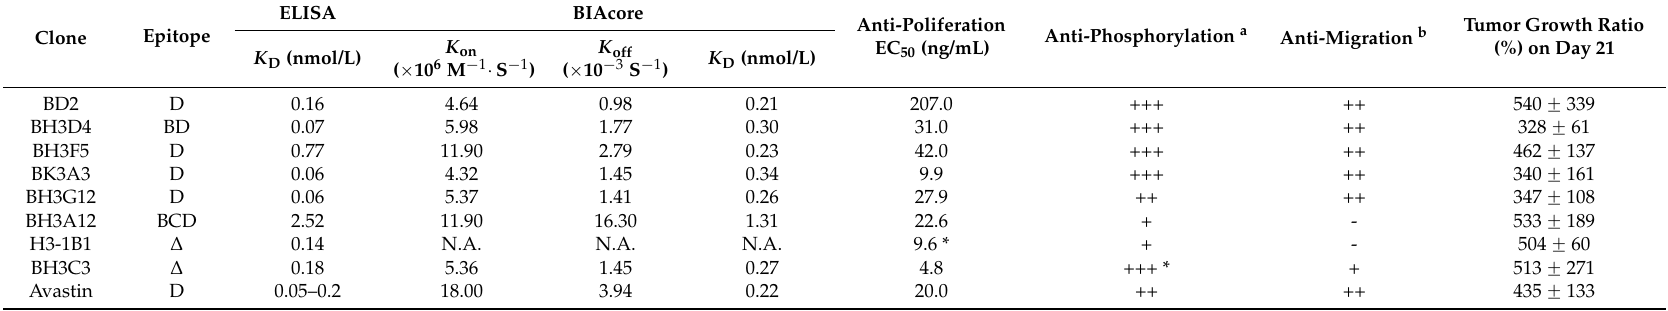
Table 2. Summary of top eight positive clones with VEGF-neutralizing activity in proliferation, phosphorylation and migration assays.